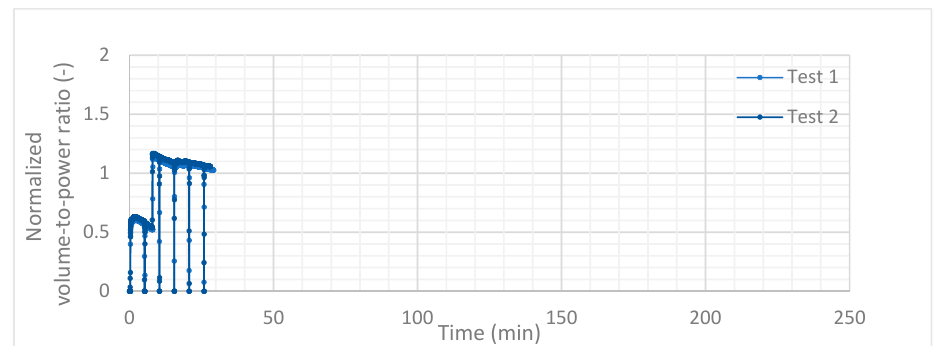
Figure A13. Normalized volume-to-power ratio at the thermostatic temperature of 0 °C.